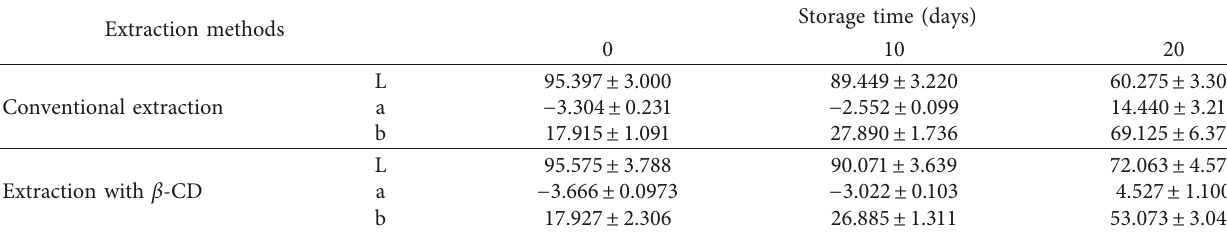
Table 1: Effects of β -CD on the color of tea infusion.